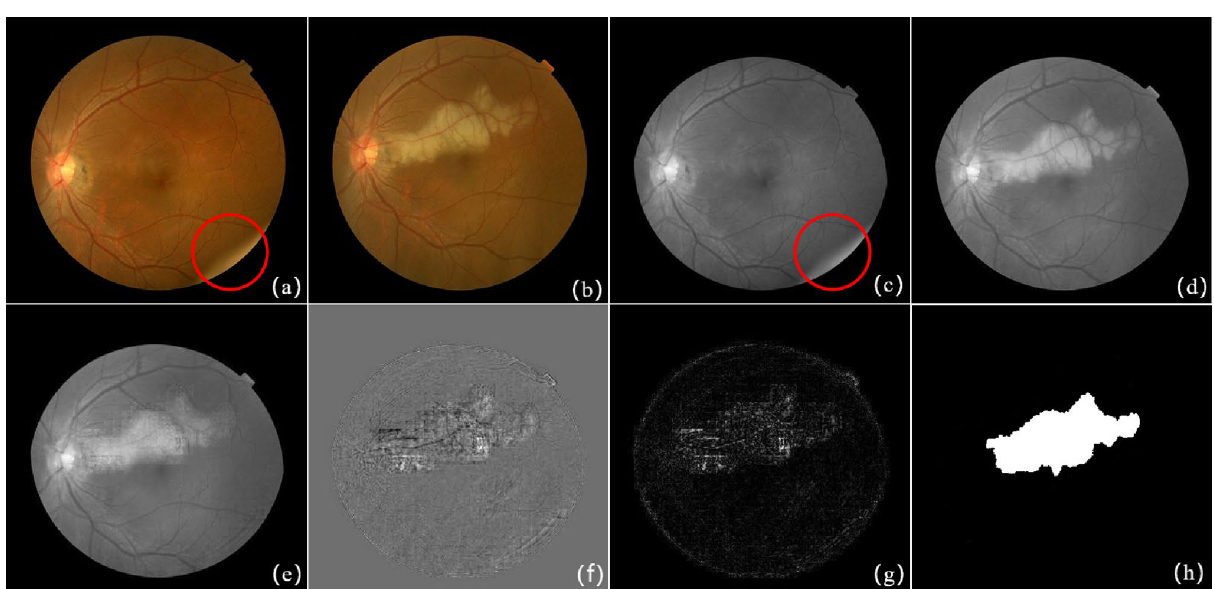
Figure 5. The result of image pair with complex lesions. ( a ) Reference image; ( b ) current image; ( c ) grayscale image of ( a ); ( d ) grayscale image of ( b ); ( e ) the reconstructed background of ( d ) based on the proposed method; ( f ) the difference image of ( d ) and ( e ); ( g ) the absolute difference image of ( d ) and ( e ); ( h ) the ground-truth.